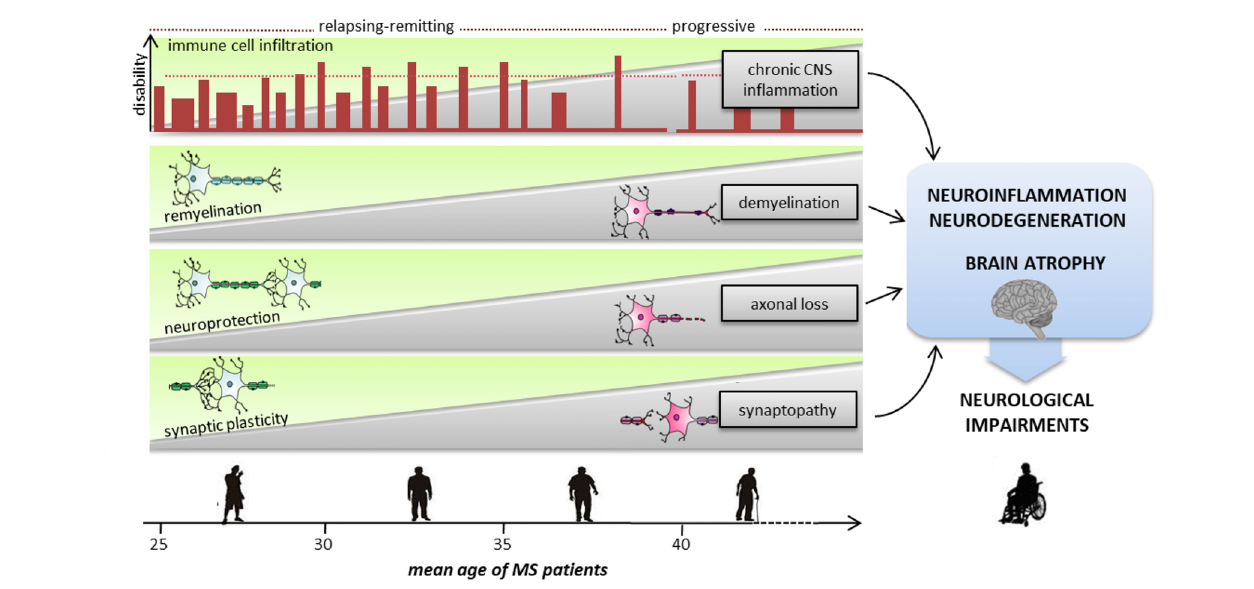
FIGURE 2 | Sequence of pathological and reparative events occurring during MS disease course, leading to severe neurological impairments. With advancing aging, neurodegenerative and neuroinflammatory processes are exacerbated causing severe cognitive and motor deficits. Inflammation is present at all stages of the disease, starting from an early phase dominated by peripheral immune cells invasion into the CNS to a progressive and chronic CNS inflammation. Since the early phase of the relapsing/remitting forms demyelination, synaptopathy and axonal damage occur causing progressive neurodegeneration. To avoid brain damage and to functionally compensate for eventual deficits of synaptic inputs, mechanisms of neuroprotection, remyelination and synaptic plasticity intervene. The transition from relapsing-remitting course MS (RRMS) to secondary progressive MS (SPMS) is likely to be the point at which the compensatory brain plasticity reserve bypassing of neuronal injury is exhausted. Usually after the fifth decade, regardless of the preceding disease course and severity, the inevitability and the rate of neurological decline are highly consistent.